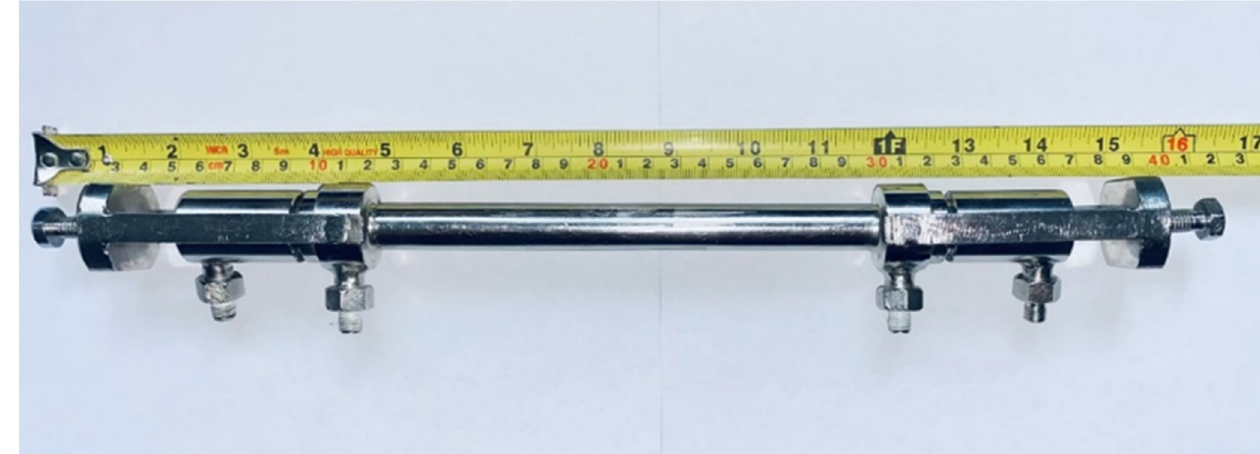
Figure 5. Laboratory-scale membrane module with PMP HFs.